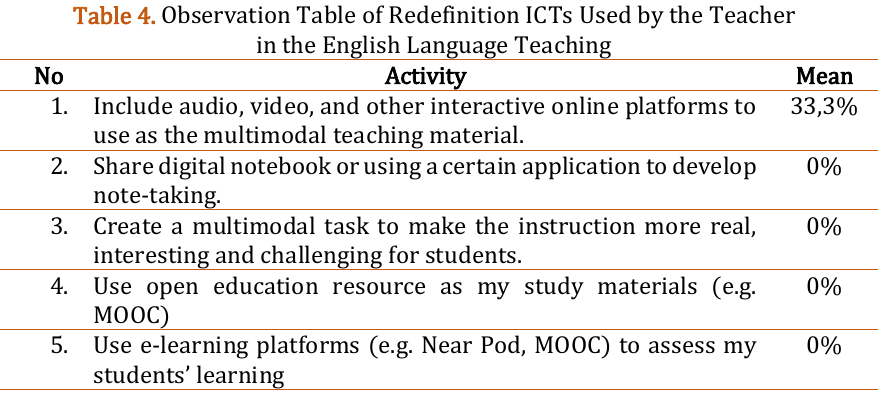
Table 4. Observation Table of Redefinition ICTs Used by the